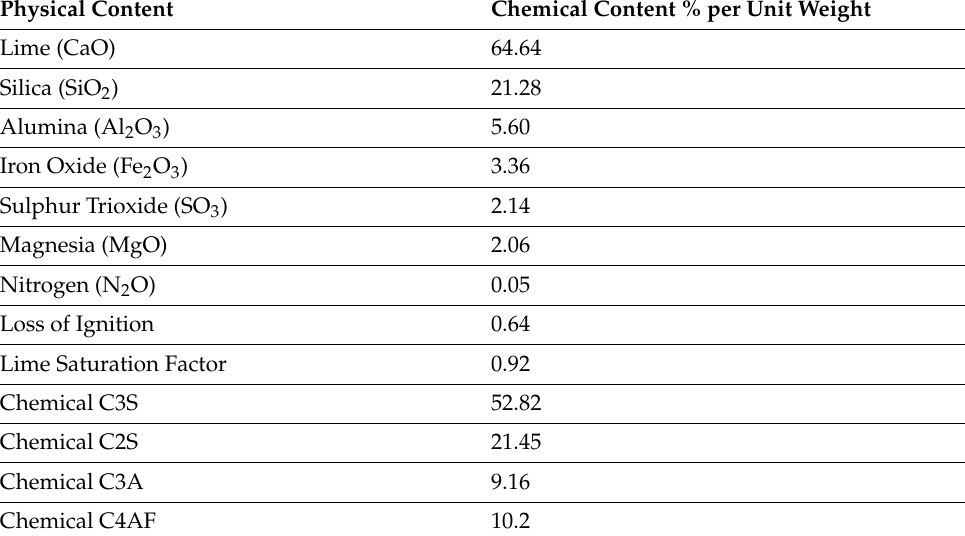
Table 2. Physics parameters and chemical composition of Ordinary Portland Cement (OPC) [52].